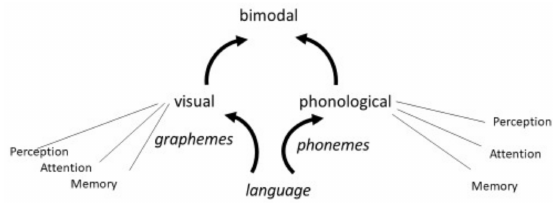
Figure 1. The three sources of dyslexia: phonological, visual, and bimodal